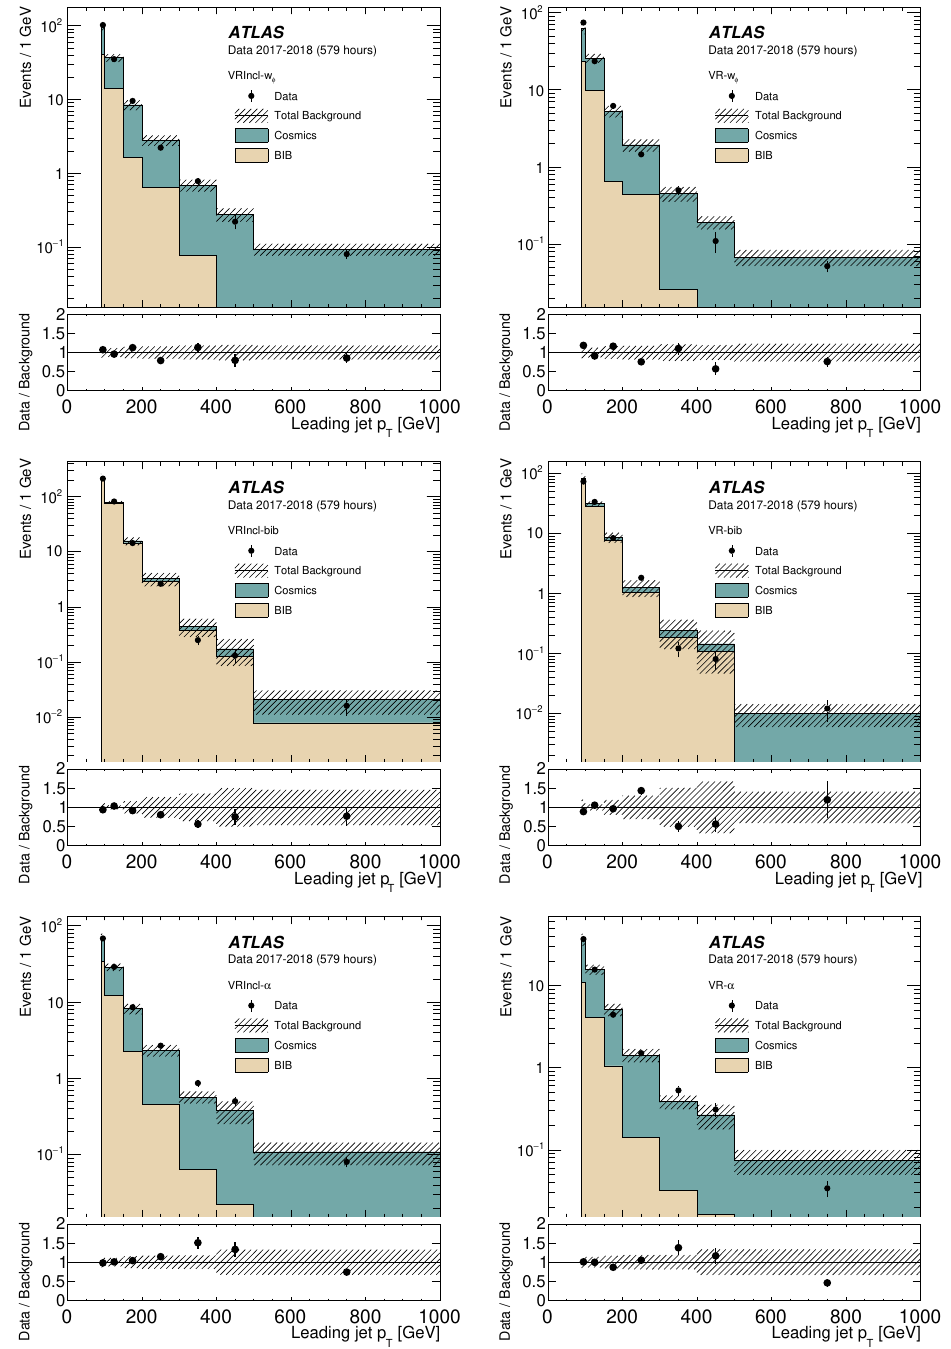
Figure 6 . The predicted leading-jet p T distributions in VR- w φ (top), VR-bib (middle) and VR- α (bottom), with the data from the 2017–2018 search sample overlaid. Each distribution includes the low- p bins corresponding to the BIB NR associated with the VR. Distributions are shown both T for an η -inclusive selection (left) and for a central (right) selection. The hatched band includes the statistical and systematic uncertainty of the background prediction. The last bin includes the overflow. The live time for the combined 2017 and 2018 empty-BX dataset is 579